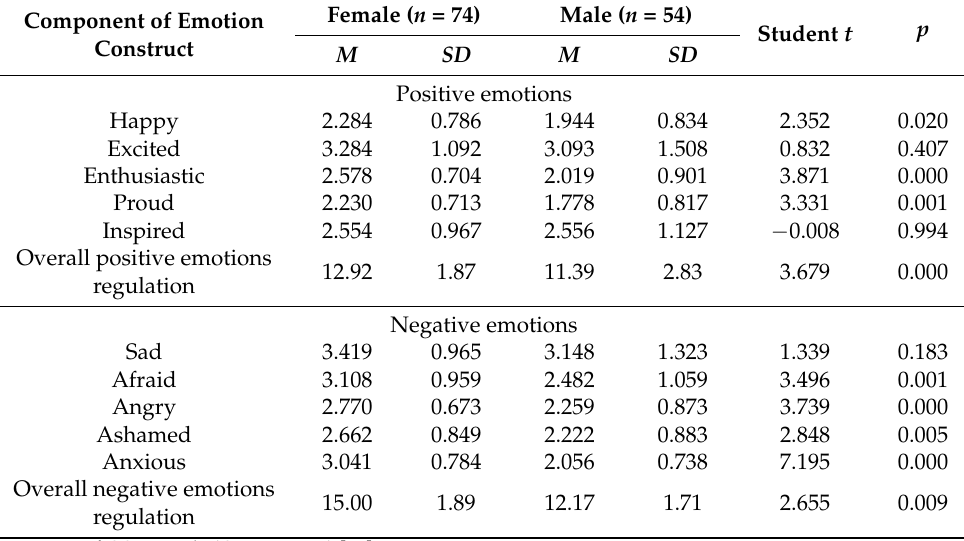
Table 4. Data on emotions regulation difficulties in terms of gender